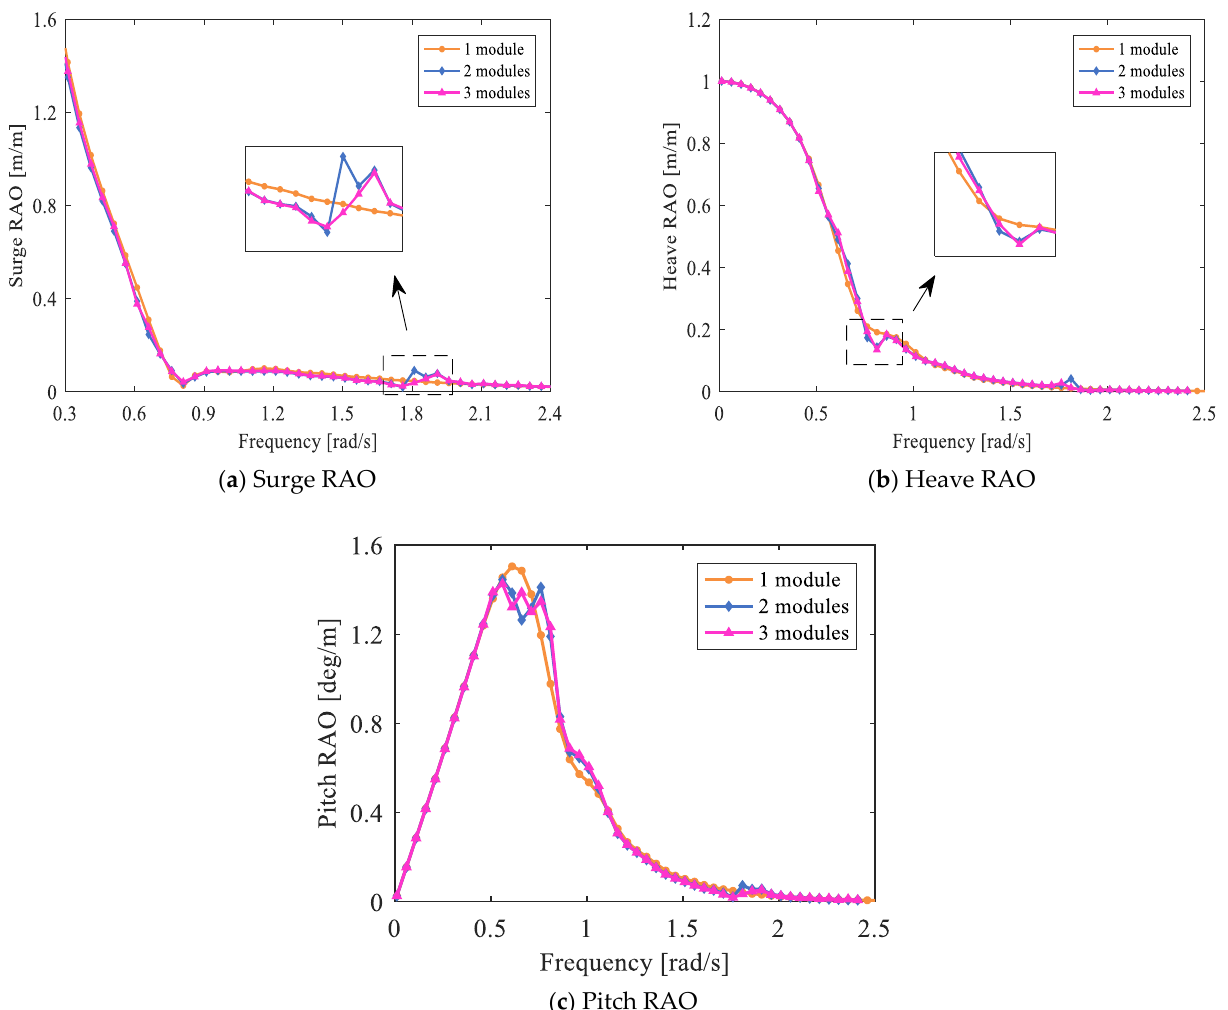
Figure 4. RAOs of the windward module in the case that the number of floating bodies is 1, 2, and 3 respectively (wave angle = 180°).